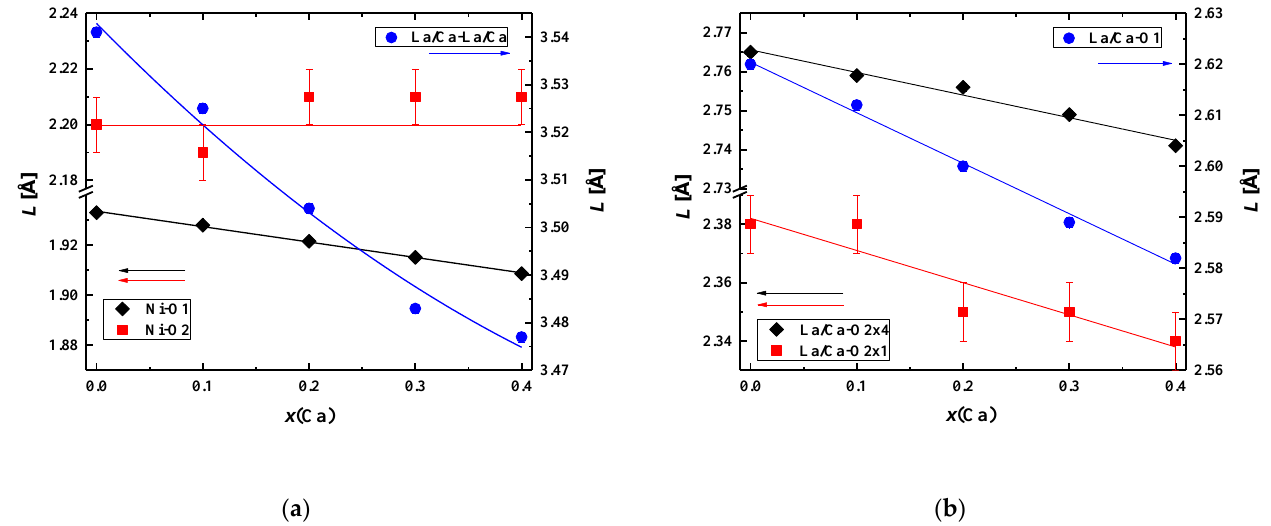
Figure 3. Ca content dependences of the Ni-O and La/Ca-La/Ca bond lengths ( a ) and the La/Ca-O bond lengths in La 2−x Ca x NiO 4+δ according to the Rietveld refinement of the XRD data ( b ).